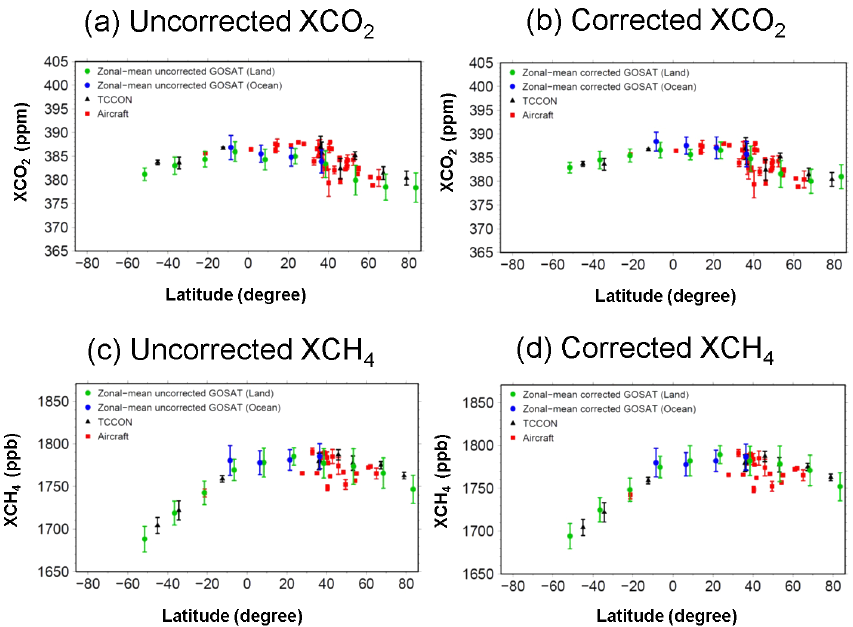
Figure 7. Latitudinal distributions of (a) uncorrected and (b) corrected GOSAT XCO 2 , TCCON XCO 2 , and aircraft-based XCO 2 in July 2009. Latitudinal distributions of (c) uncorrected and (d) corrected GOSAT XCH 4 , TCCON XCH 4 , and aircraft-based XCH 4 in July 2009. Green and blue circles indicate the zonal-mean GOSAT data retrieved over land and ocean regions, respectively. The black triangles and red squares denote the TCCON data and aircraft-based data, respectively, at each observation site. See text for details.